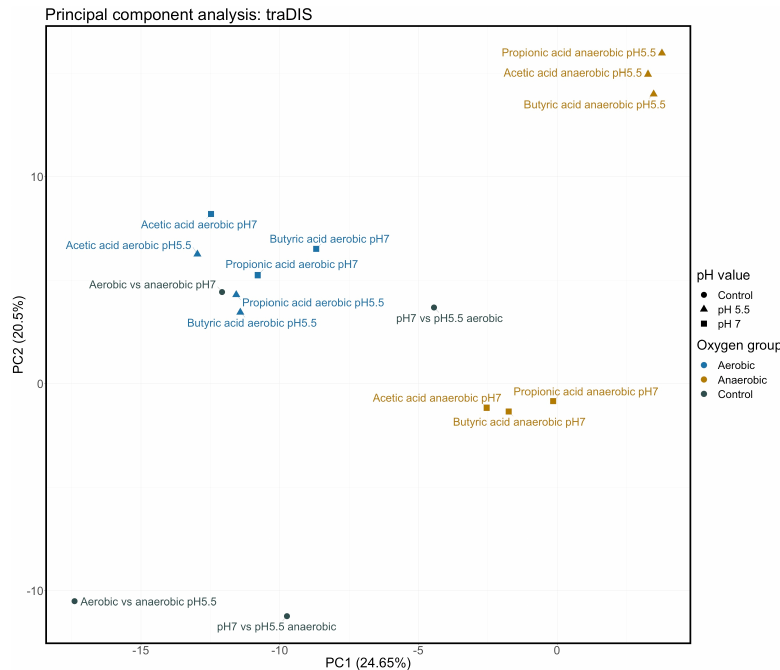
Figure 5. Principle component analysis of TraDIS data. TraDIS data, as used in clustering in Figure 4, were also analysed using principle component analysis as described in Materials and Methods. This figure shows the first two components (PC1 and PC2) in this analysis.